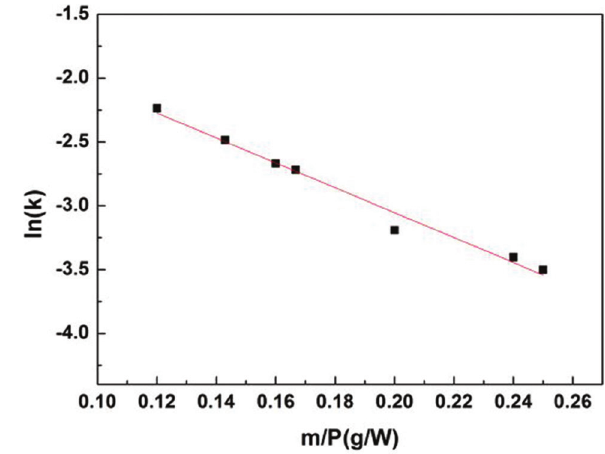
Figure 7: Comparison of the experimental date with the predicted Midilli-Kucuk equation.